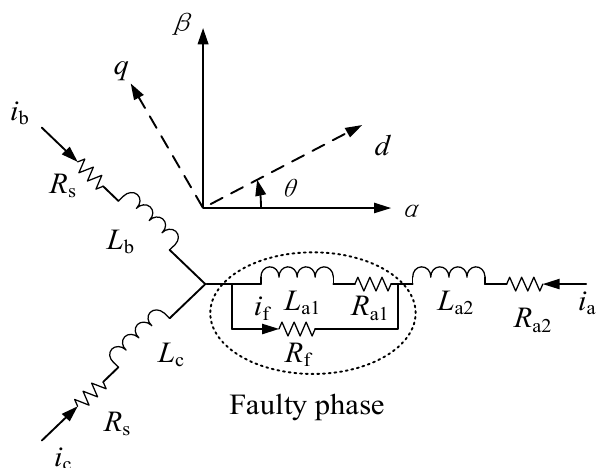
Figure 1. Model of an a-phase inter-turn short-circuit fault in a permanent magnet synchronous motors (PMSM).